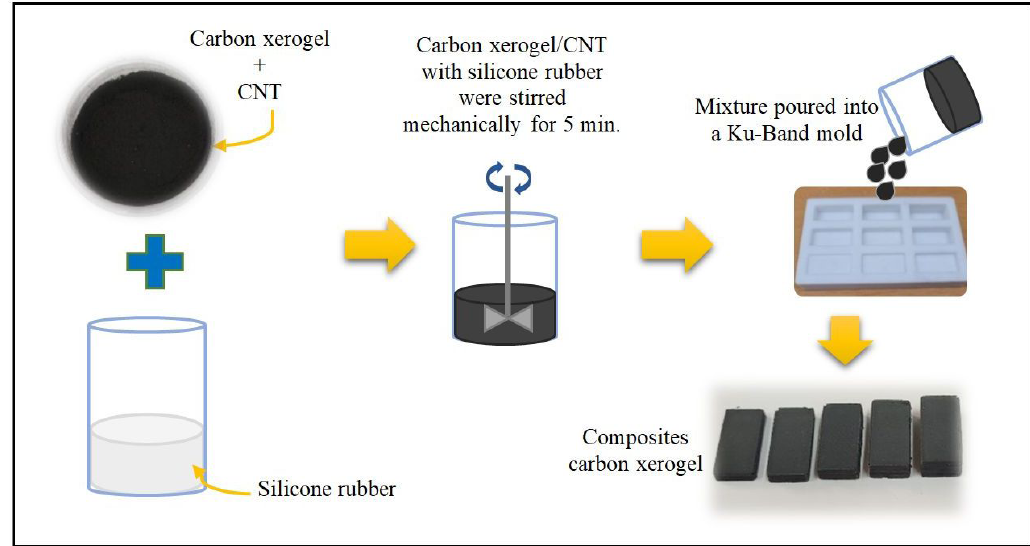
Figure 2. Production process of composites